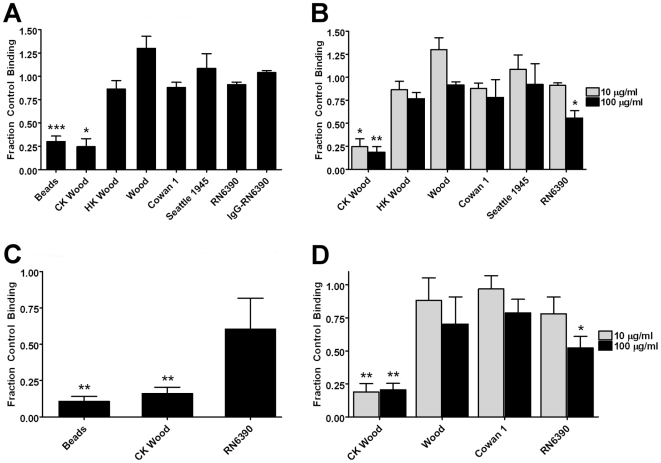
Effect of poly(I) on binding of S. aureus strains by macrophages: quantitative results.Macrophages were treated with 10 or 100 µg/ml poly(I) or its negative control chondroitin sulfate prior to and during incubation with either fluorescent latex beads or S. aureus. Bars represent the mean of the fraction of chondroitin sulfate control binding [particles per cell for adherent cells (A,B,D) and mean fluorescence increase over that of cells without particles for cells in suspension (C)] of three normal donors±SEM. (A) Results of inhibition by 10 µg/ml poly(I) of binding by adherent GM-MФs. (B) Results of inhibition by 10 vs. 100 µg/ml poly(I) of binding by adherent GM-MФs. (C) Results of inhibition by 10 µg/ml poly(I) of binding by GM-MФs in suspension. (D) Results of inhibition by 10 vs. 100 µg/ml poly(I) of binding by adherent mouse peritoneal macrophages. *p<0.05, **p<0.01, ***p<0.001 compared to negative control. CK Wood = commercial killed AlexaFluor 488-conjugated S. aureus, Wood Strain. HK Wood = heat-killed S. aureus, Wood strain.